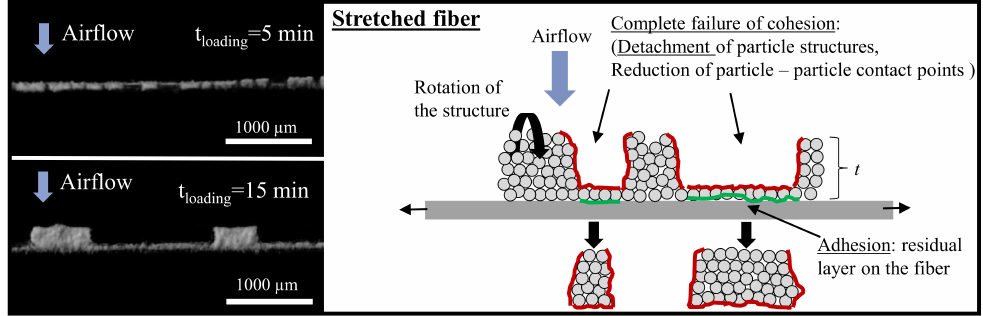
Figure 9. ( LEFT ): Images (side view) of the loaded fiber after 5min loading time (TOP) and after 15min loading time (BOTTOM) at 20% fiber elongation during the second stretching cycle. Same elongation velocity of 0.6mm s − 1 . Illumination of structure from the front. ( RIGHT ): Schematic of the loaded fiber in the stretched state. Marked the physical state at the interfacial